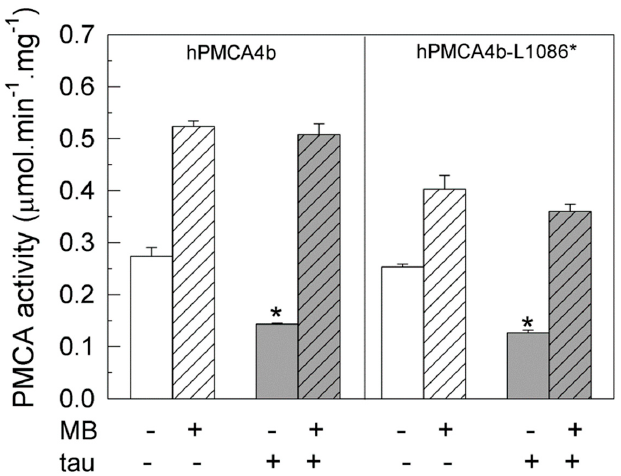
Figure 4. Activities of intact and truncated hPMCA4b isoforms are differentially regulated by tau and MB. Membranes (20 µg) prepared from COS-7 cells over-expressing the native human PMCA4b and truncated hPMCA4b-L1086* and hPMCA4b-R1052* isoforms were incubated, as previously described, without (white bars) or with 7.5 nM tau (grey bars). Activities were assayed by successive additions of 1 mM ATP and 100 µM MB (striped bars) as indicated and are expressed in µmol.min − 1 .mg − 1 protein mean ± SE of four experiments performed with four preparations. * p < 0.001 vs. control.